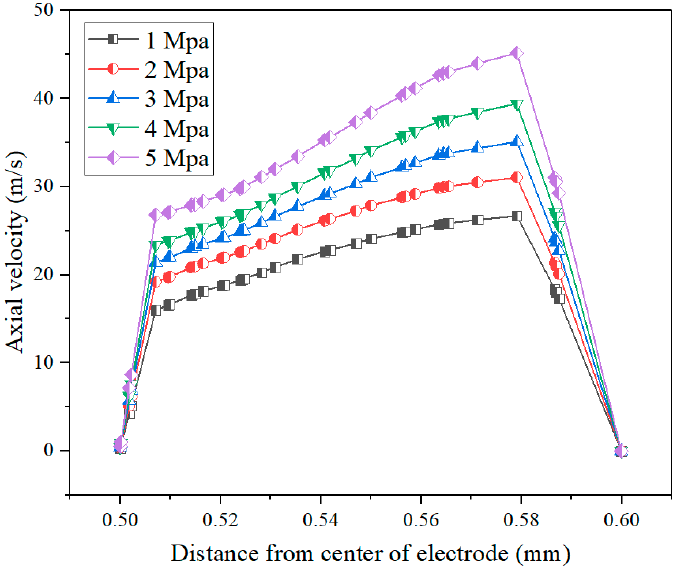
Figure 5. Axial velocity distribution of working fluid along sample lines at different flushing pressures.